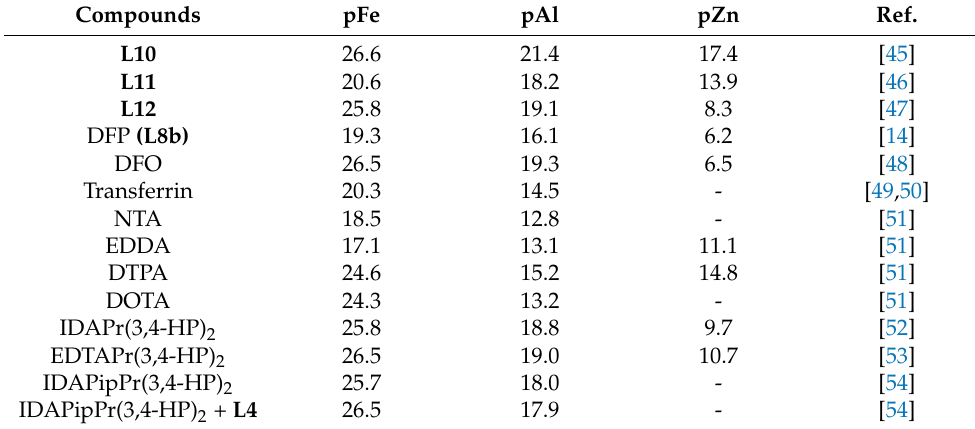
Table 3. pM values reported in literature for bis-3,4-HPs and commercial metal chelators. Compounds